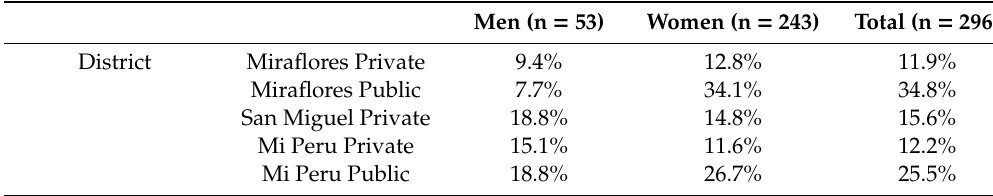
Table 2. Sociodemographic characteristics of the